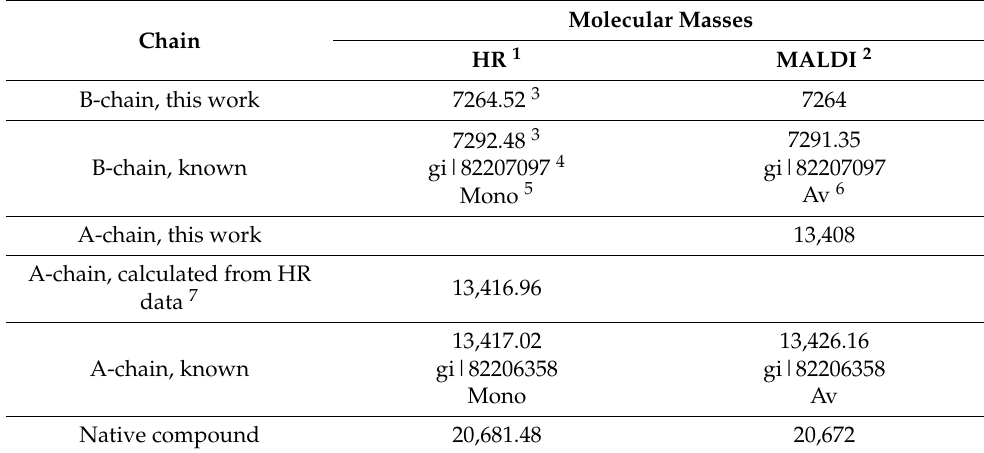
Table 1. Molecular masses of toxin IV-18-2 subunits (Da). Chain